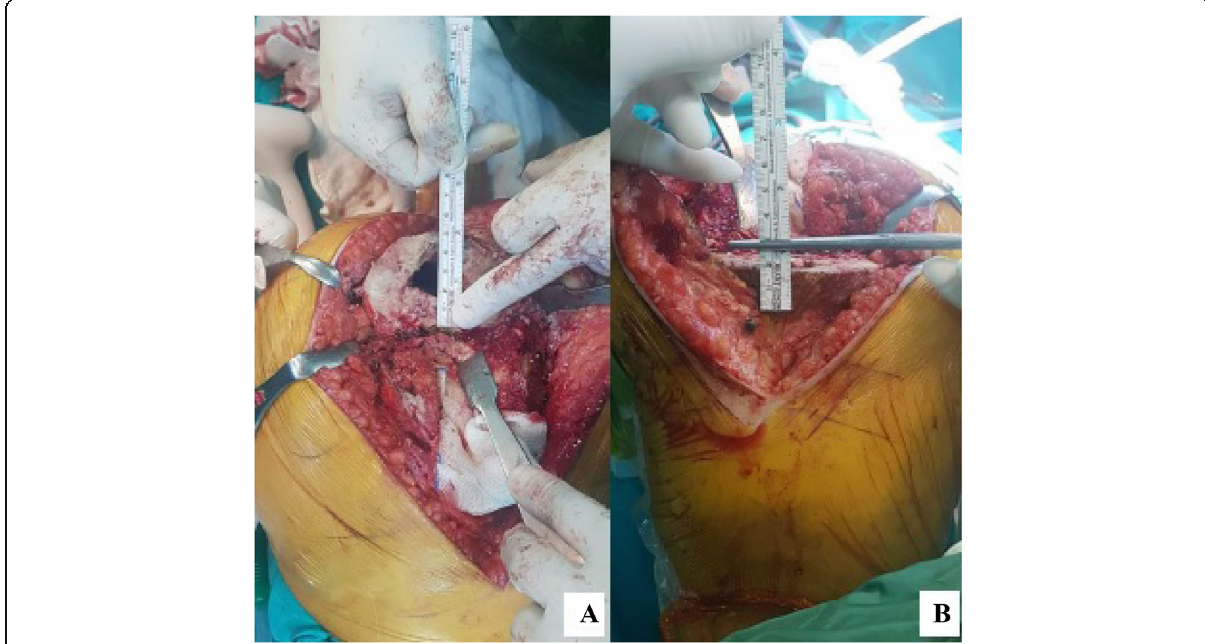
Fig. 5 a. Measuring the anterior-posterior length of the tibia. b. JL restoration according to